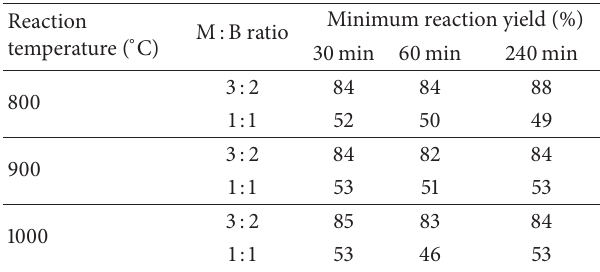
Table 4: Minimum reaction yields (%) based on “K.”